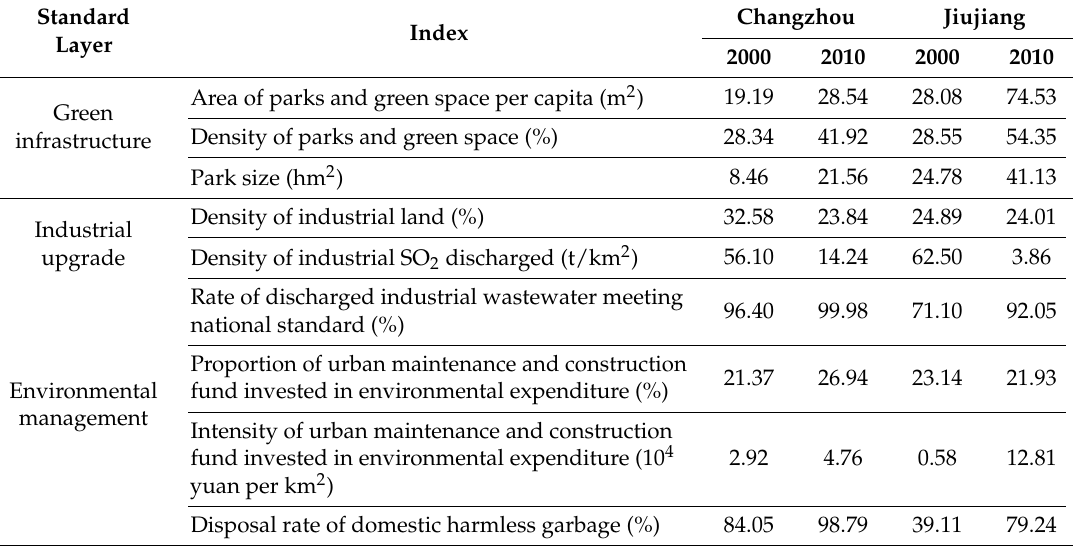
Table 5. The original values of assessment indices of environmental benefits of urban land use, Changzhou and Jiujiang.